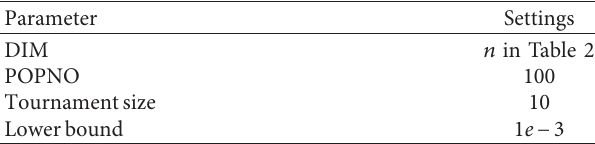
Table 1: EP parameter